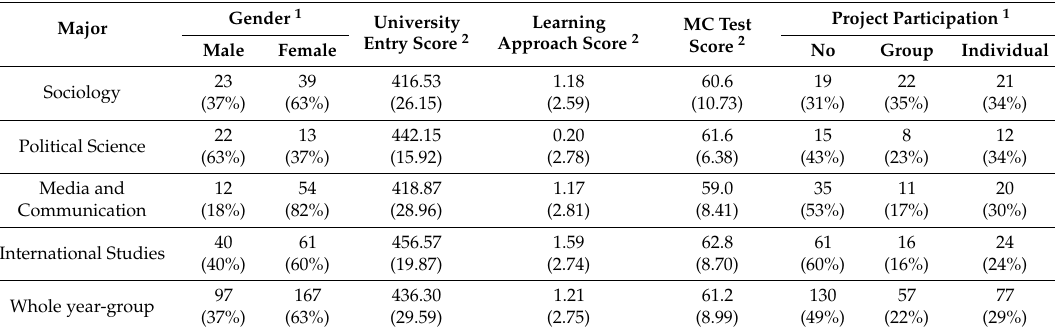
Table 2. Quantitative overview of the sample.